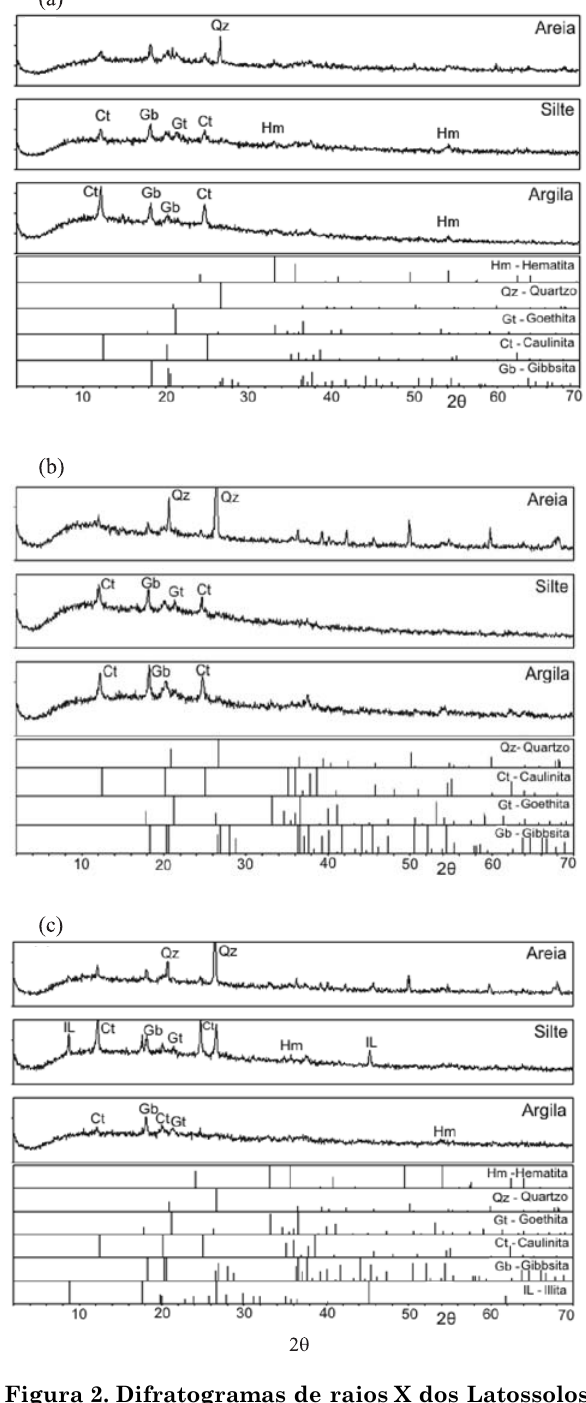
Figura 2. Difratogramas de raios X dos Latossolos das topossequências Fazenda Água Limpa (FAL) e Sobradinho: (a) frações areia, silte e ar- gila do horizonte B do LV da topossequência w FAL; (b) frações areia, silte e argila do horizonte B do LV da topossequência Sobradinho; (c) fra- w ções areia, silte e argila do horizonte BC do LVA da topossequência FAL. As barras representam a posição característica (valor 2 θθθθθ ) e a intensida- de dos picos dos minerais nos